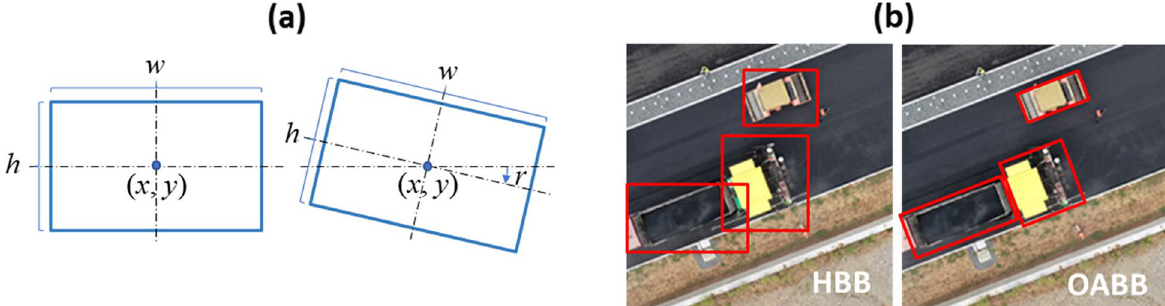
Fig. 1 Difference between HBB and OABB: ( a ) description parameters, ( b ) equipment